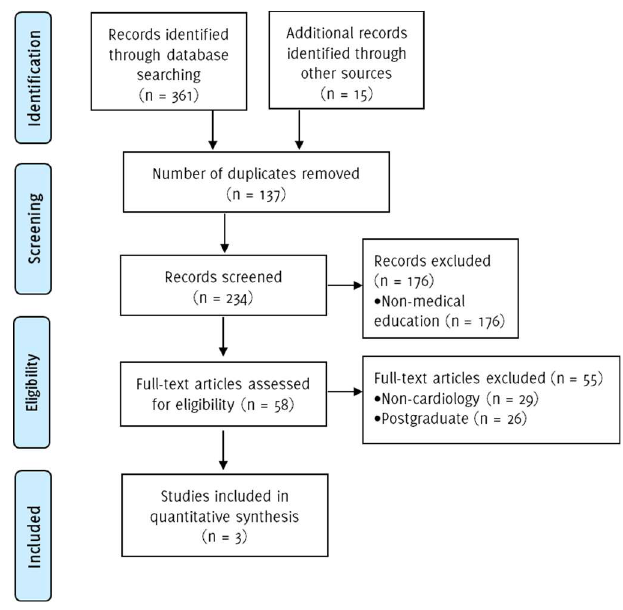
Figure 2 . Literature Search. Keywords included “medical student”, “medical students”, “cardiology”, “career choice”, “career choices” and